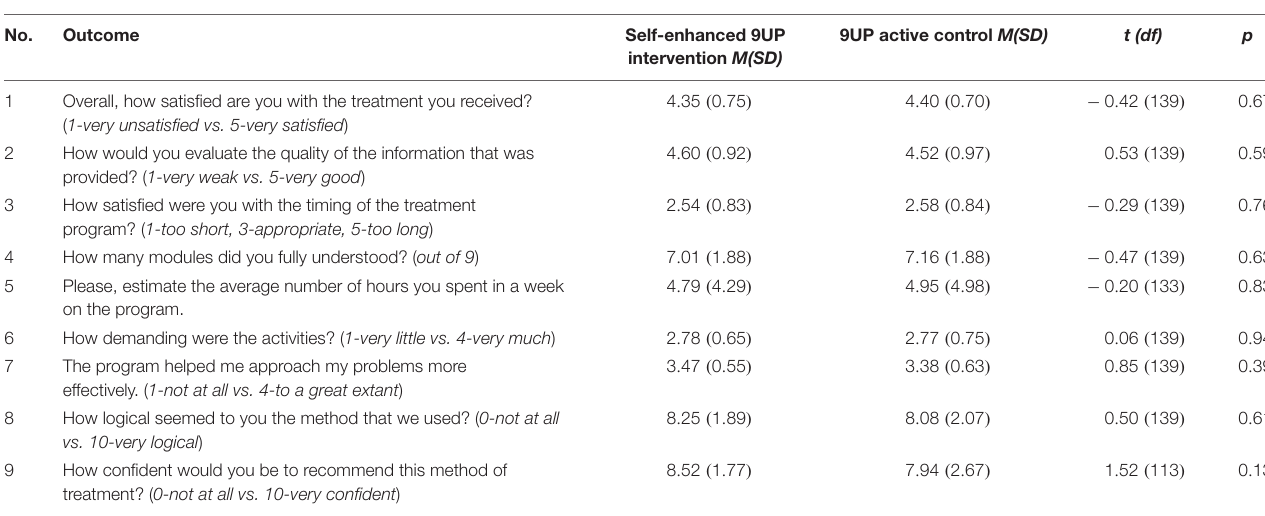
TABLE 6 | Descriptive statistics for the treatment satisfaction